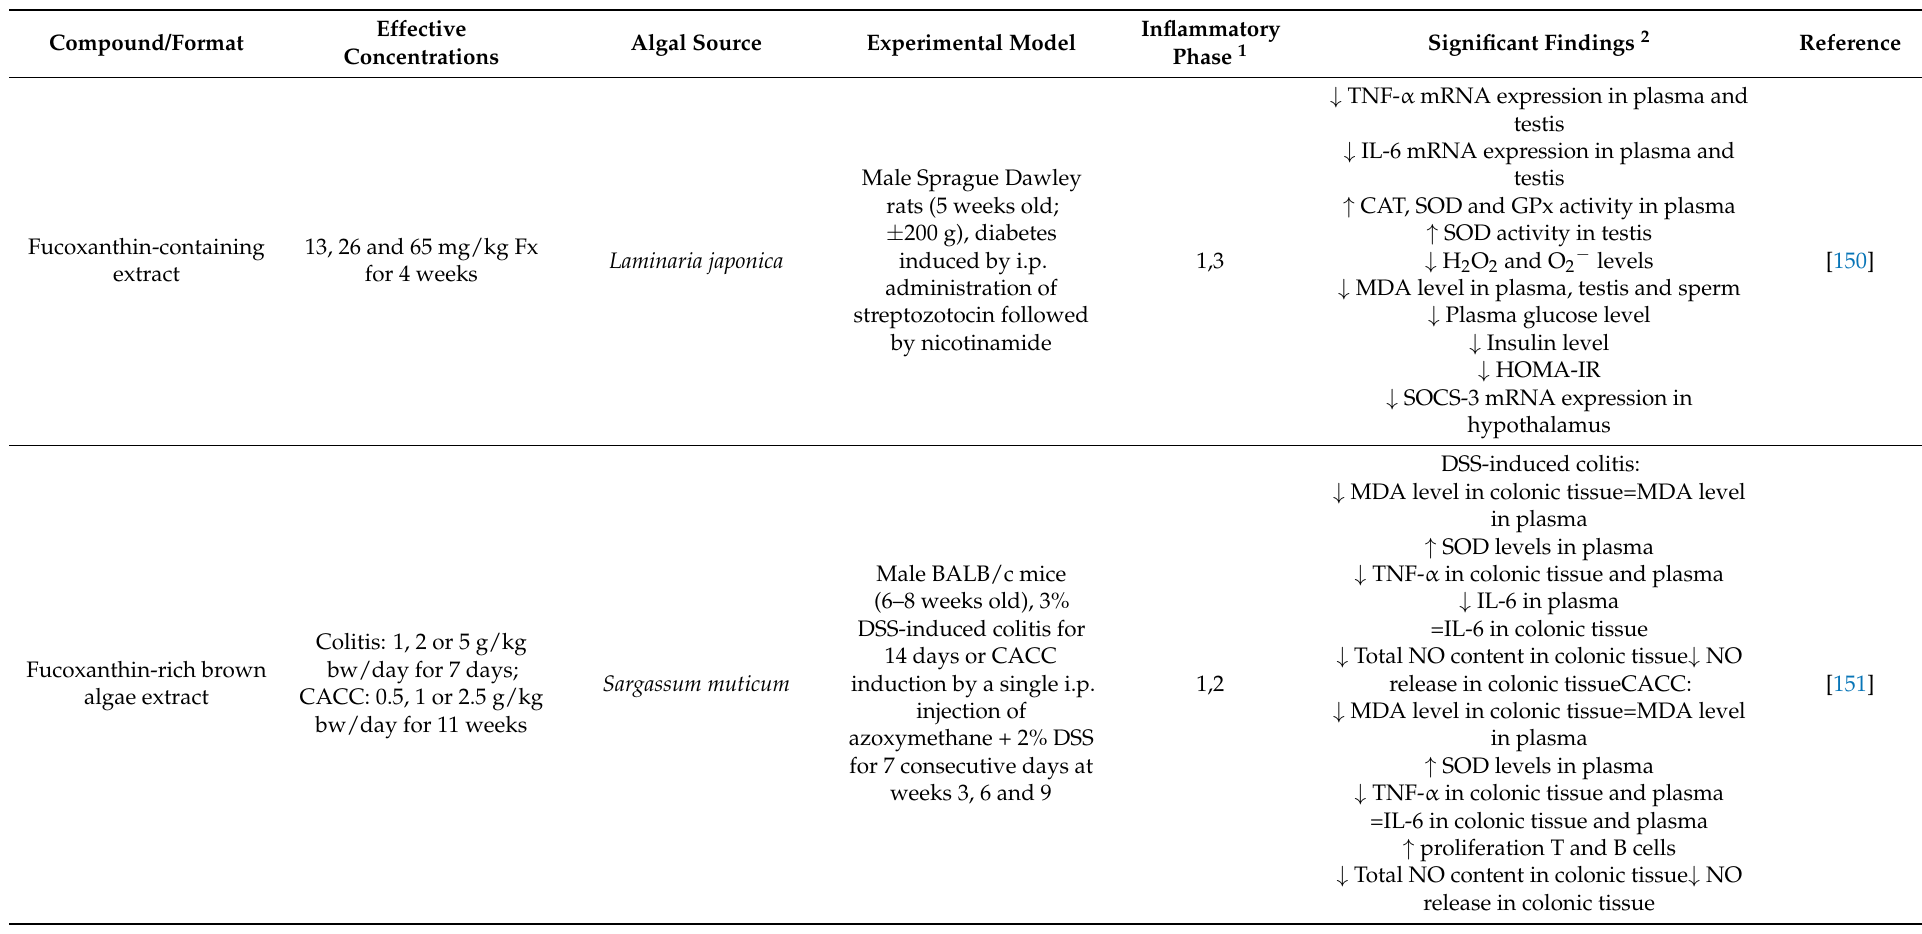
Table A5. Effects of oral supplementation of brown seaweed derived Fucoxanthin(ol) and Meroterpenoid on inflammation-related